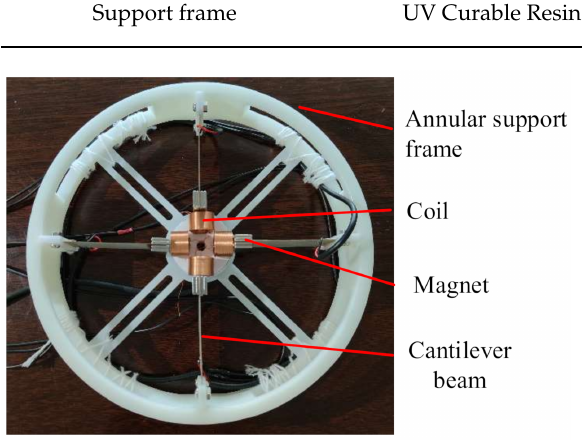
Figure 6. Physical diagram of the ring piezoelectric electromagnetic harvester.